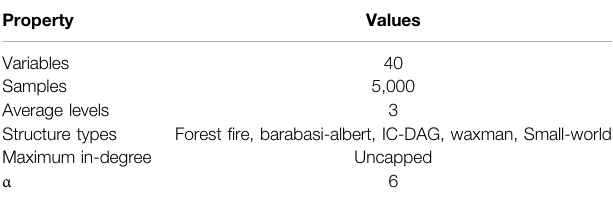
TABLE 7 | The values used for each property when creating synthetic BNs (and theirassociateddatasets)fortheALARMdatasheet.Combinatorialtotalof fi ve property values, Each con fi guration of properties was repeated 10 times. In total 50 Bayesian networks and datasets were created. Property